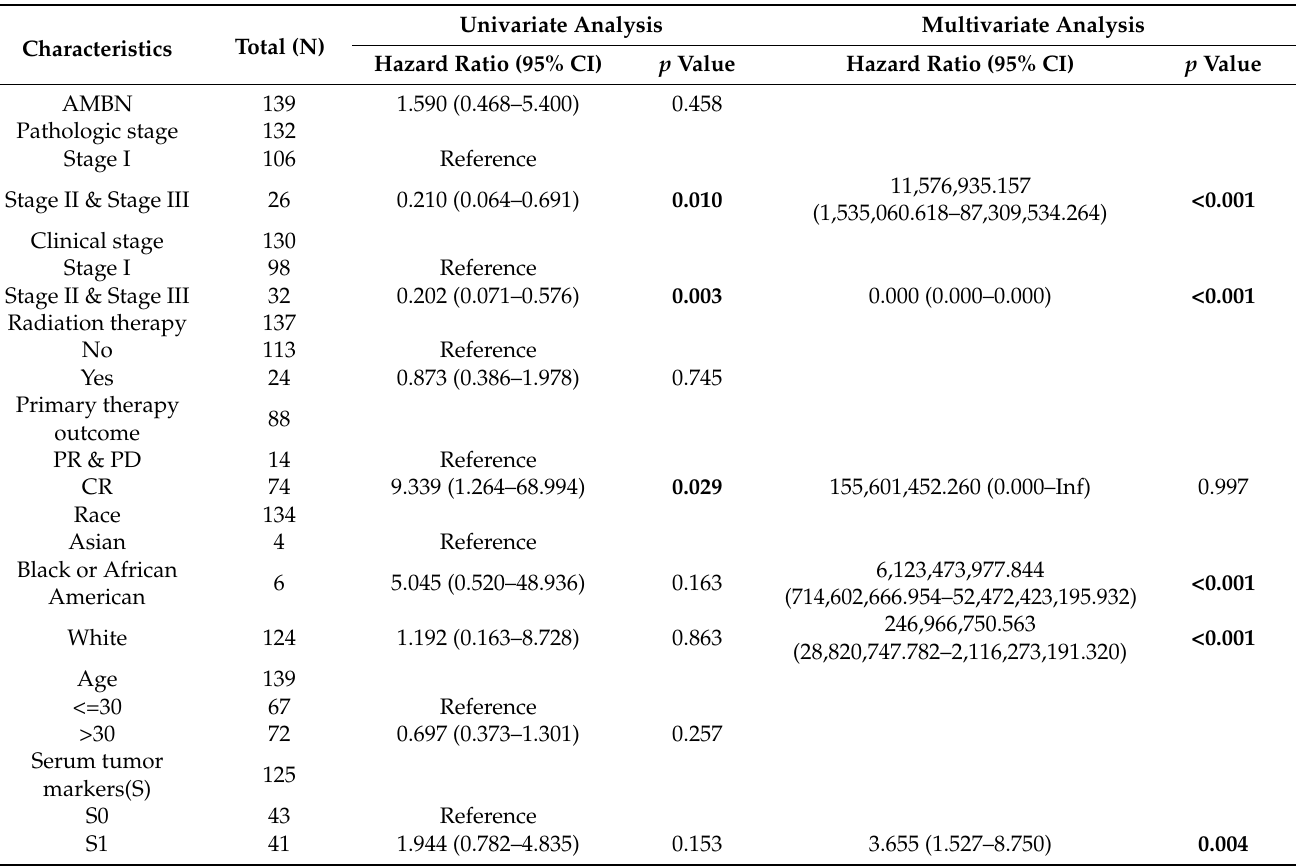
Table 1. Baseline information sheet for AMBN, assessing the difference in the composition ratios of the high and low AMBN mRNA expression subgroups in the different TGCT clinical